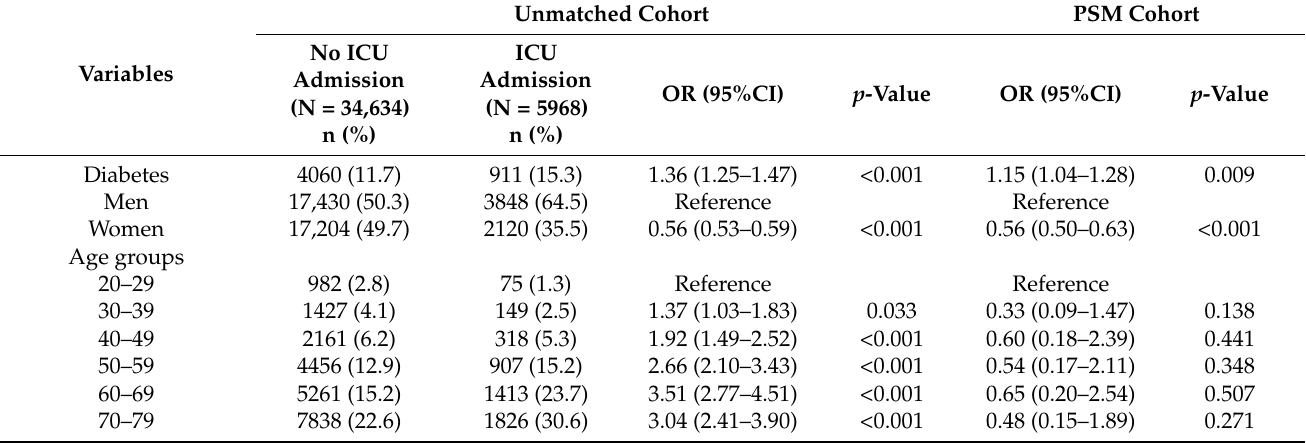
Table 2. Comparison and simple logistic regression analysis of ICU admission with diabetes and other variables in unmatched and propensity score matched